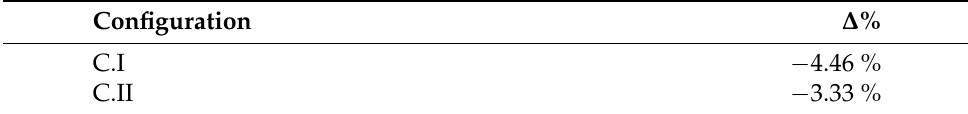
Table 10. Percent difference of time to bank 45° for aircraft C.I and C.II with respect to